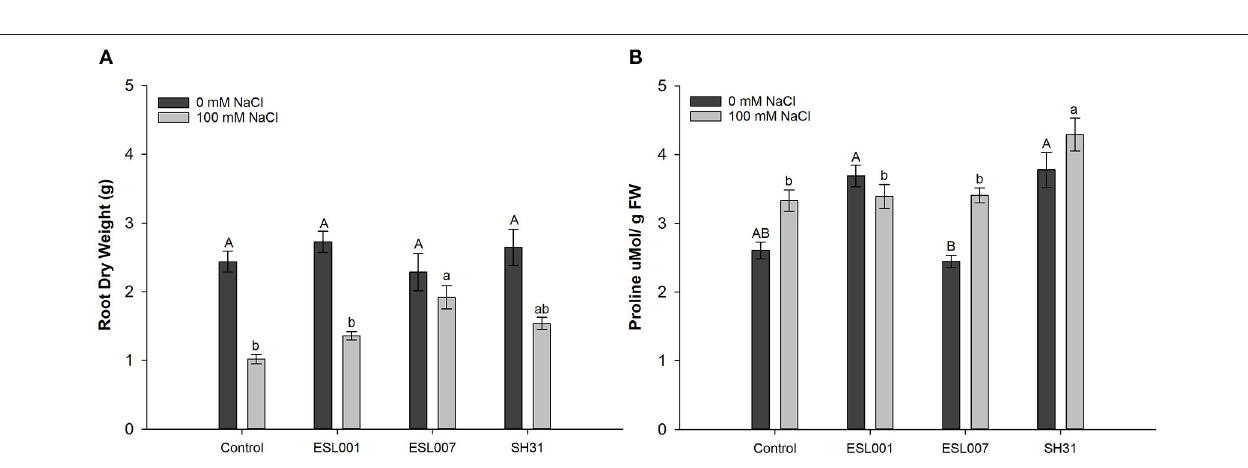
FIGURE 2 | Effect of bacterial treatments on root dry weight (A) and proline content (B) in the lettuce pot experiment under salt stress (0 and 100mM NaCl in soil). (a) Root dry weight, (b) Proline content. Data are presented as means of 15 individuals per treatment with standard errors. Letter(s) indicate statistical significance according to ANOVA at p <